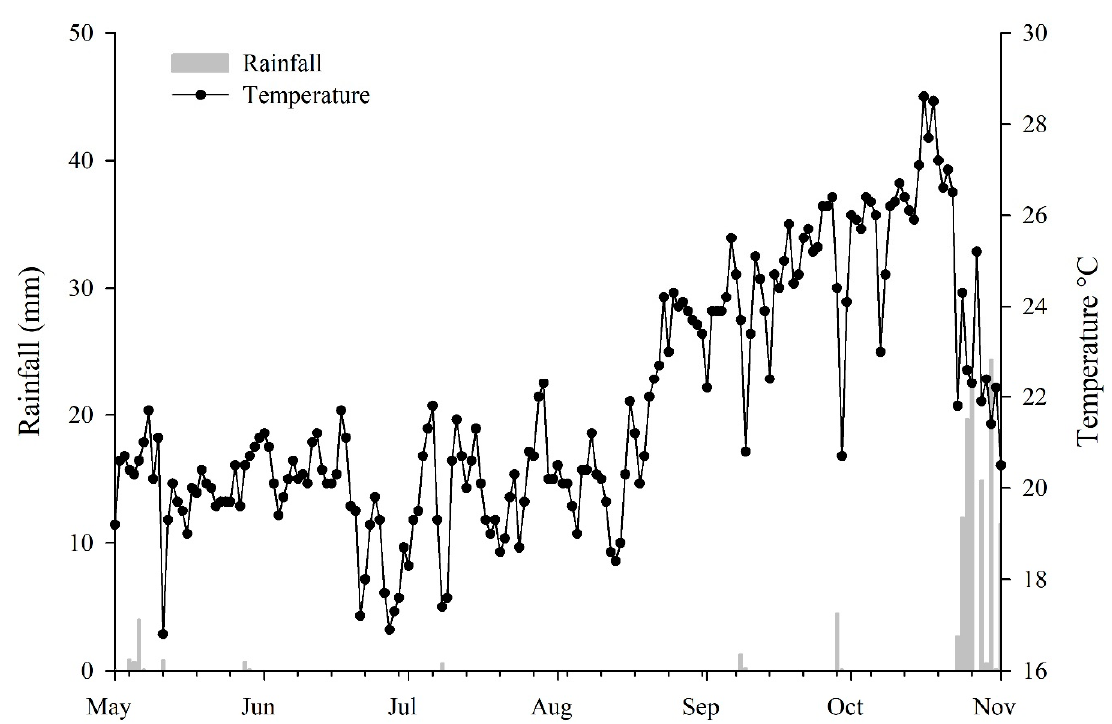
Figure 1. Average precipitation and temperature of the experimental area from May to November 2015. Data were obtained from an automatic station located next to the experimental area.